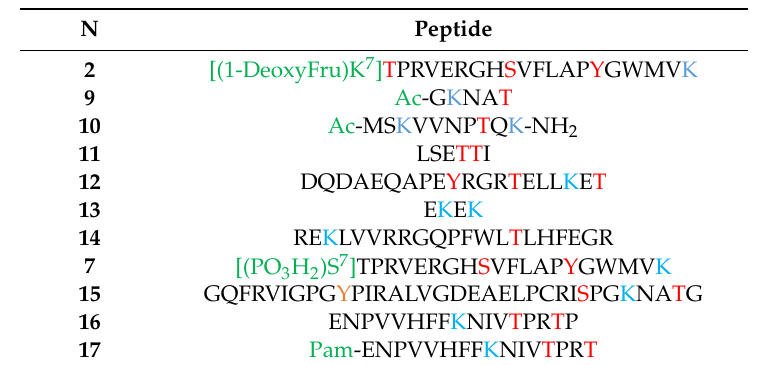
Table 4. Synthetic peptides used as a matrix for capturing [(1-DeoxyFru)Lys 7